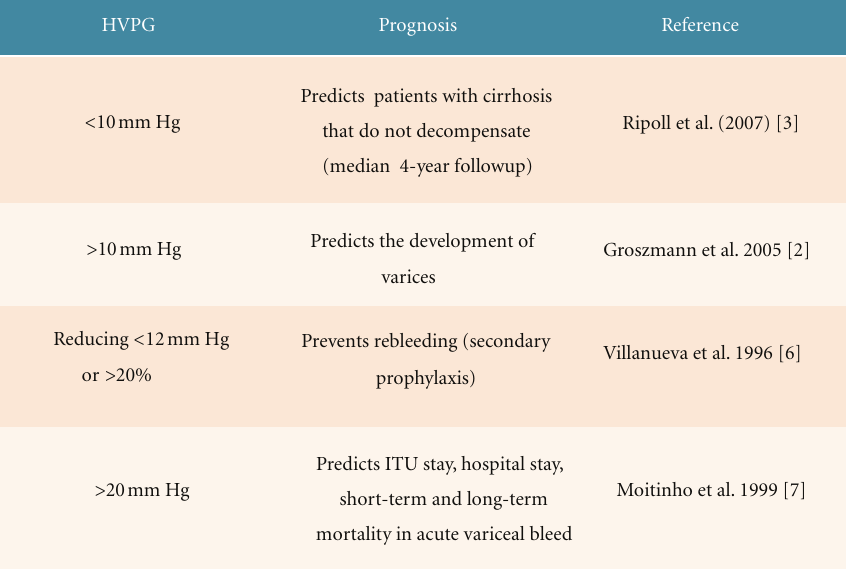
Figure 1: Clinical importance of portal